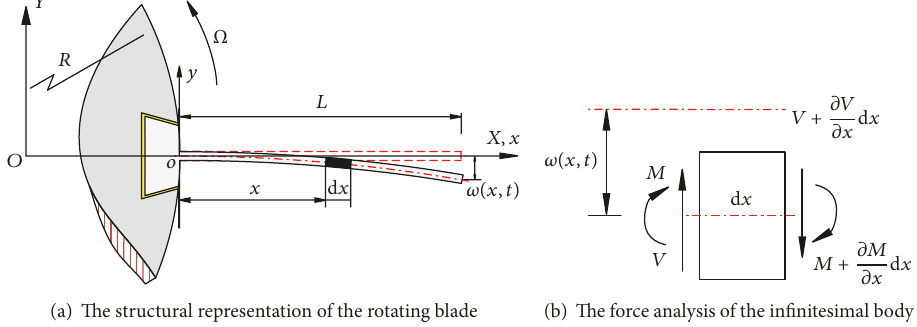
Figure 1: The continuous model of the blade with dovetail